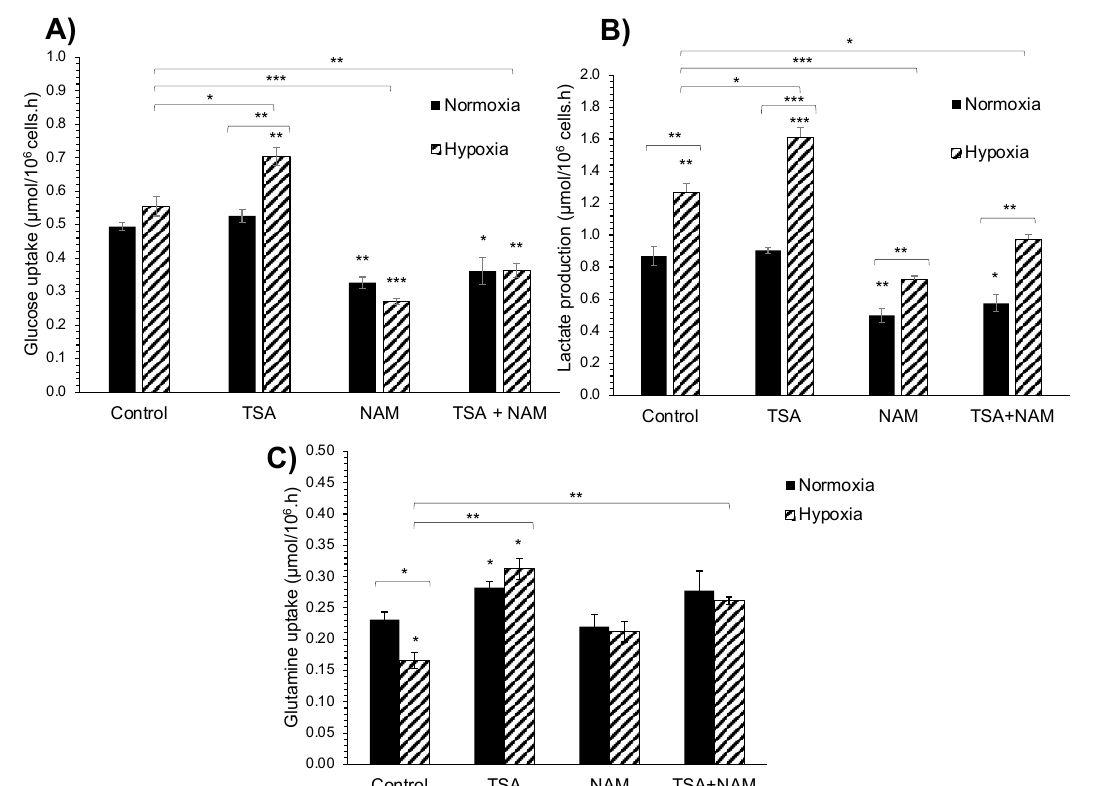
Figure 2. Extracellular metabolite quantitation of KDACI-treated A549 cells under normoxia and hypoxia. The glucose uptake ( A ), lactate production ( B ), and glutamine uptake ( C ) were measured in the beginning and at the end of the 24 h- incubation, and the metabolite consumption/production rates were normalized by the number of cells in each condition. ( A – C ) A549 cells were treated with 1 μ M TSA, 20 mM NAM, or both 1 μ M TSA and 20 mM NAM for 24 h under normoxia or hypoxia. Bars represent the means ± standard error of the mean of three independent experiments. The asterisks above bars indicate statistically significant differences compared to normoxic control cells. The asterisks above curly brackets indicate statistically significant differences between hypoxic and normoxic treatments and between hypoxic treatments and hypoxic control cells. Statistical significance was assessed by a two-tailed Student’s t -test. * p ≤ 0.05; ** p ≤ 0.01; *** p ≤ 0.001.